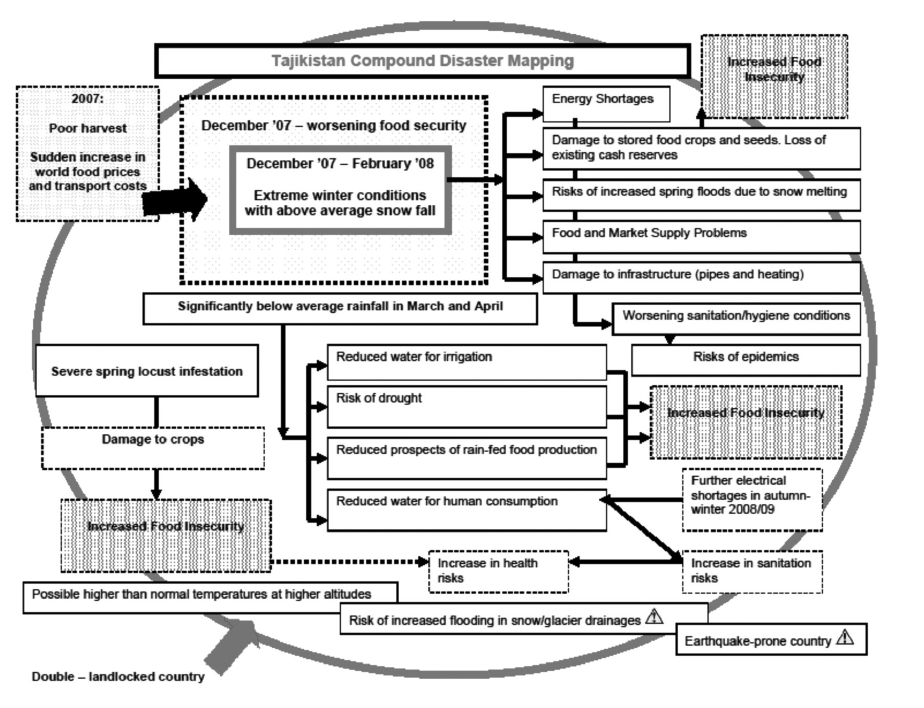
Fig 1. Tajikistan Disaster